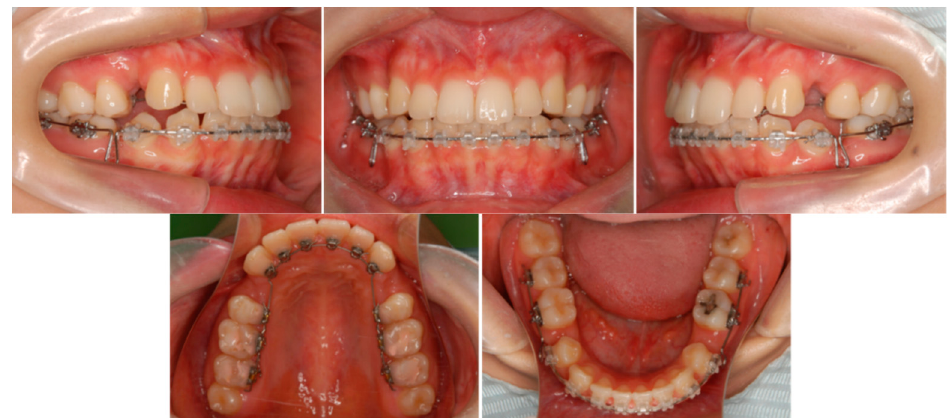
Figure 12. Progress intraoral photographs after 2 months of start of active treatment.